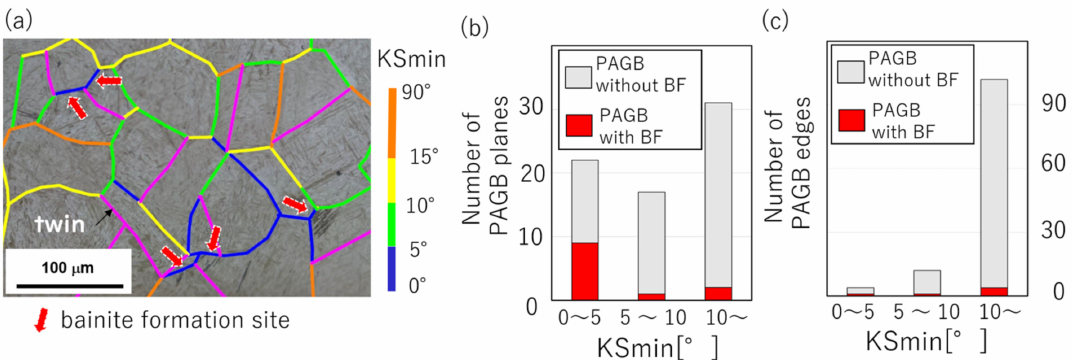
Figure 7. ( a ) OM image with PAGBs colored by the KSmin value, (blue: 0 ◦ to 5 ◦ , green: 5 ◦ to 10 ◦ , yellow: 10 ◦ to 15 ◦ , orange: bigger than 15 ◦ : purple: twin boundaries) and red arrows show the PAGBs where BFs were formed. The distribution of the KSmin values of PAGB and the formation tendencies of BFs at each KSmin value at PAGB ( b ) planes and ( c )